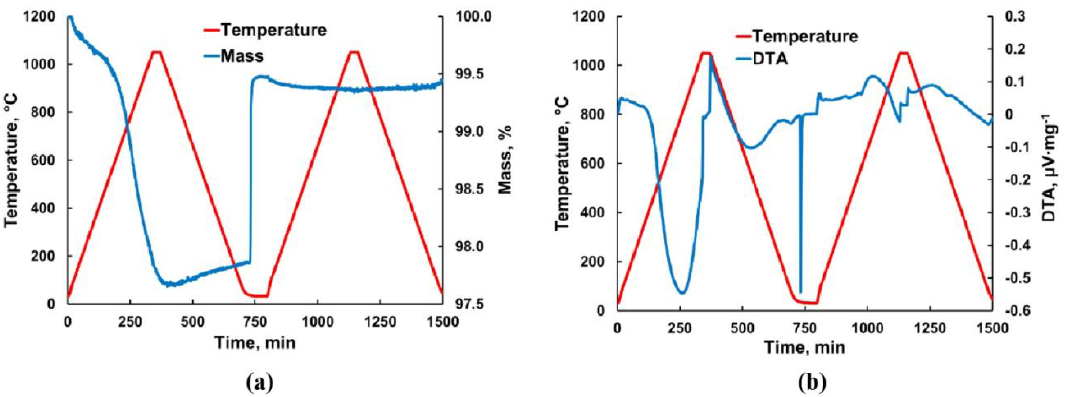
Figure 4. (a) Mass change and (b) differential thermal analysis of GDC10-HP powder during Figure 4. ( a ) Mass change and ( b ) di ff erential thermal analysis of GDC10-HP powder during reduction reduction in Ar-2.9%H 2 in first thermal cycle and re-oxidation in air in second thermal cycle. in Ar-2.9%H 2 in first thermal cycle and re-oxidation in air in second thermal